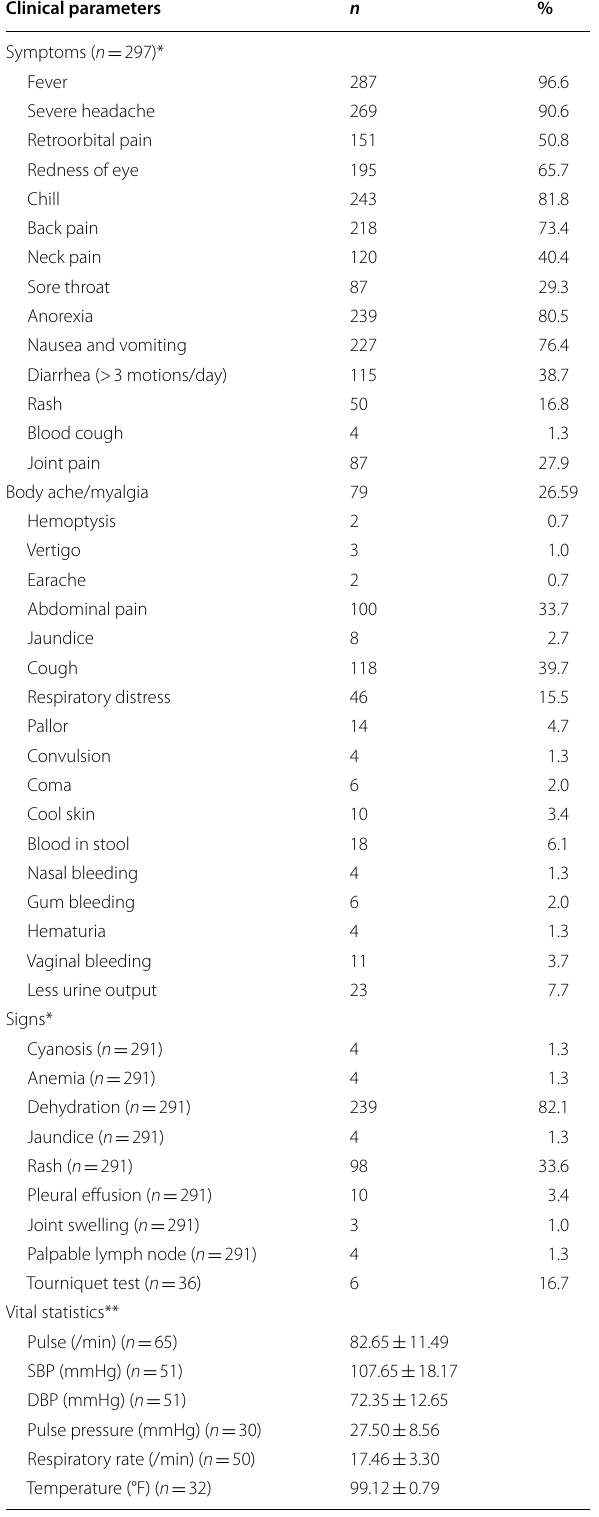
Table 2 Clinical parameters of dengue patients on admission Clinical